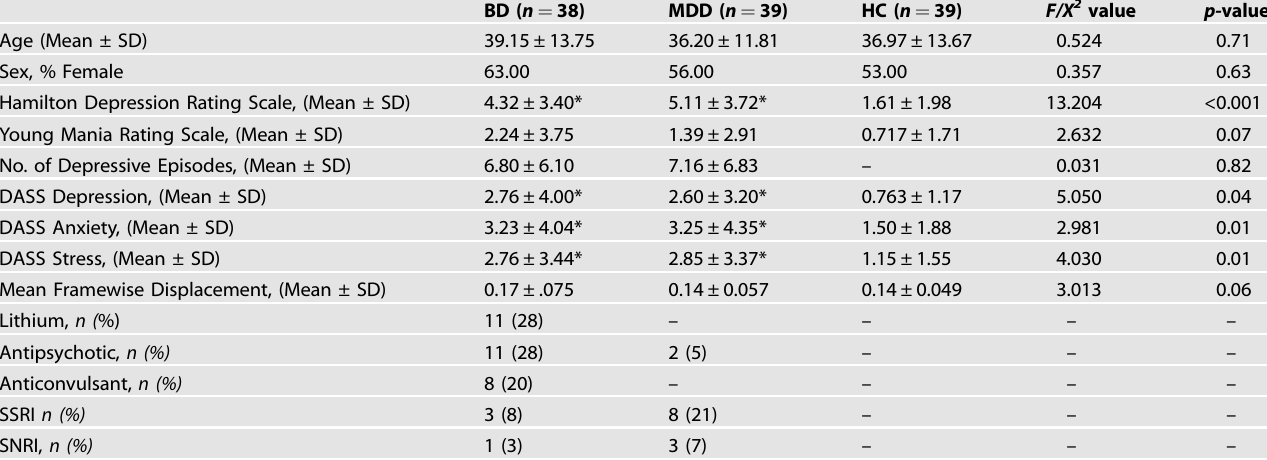
Table 1. The demographics and clinical characteristics of all